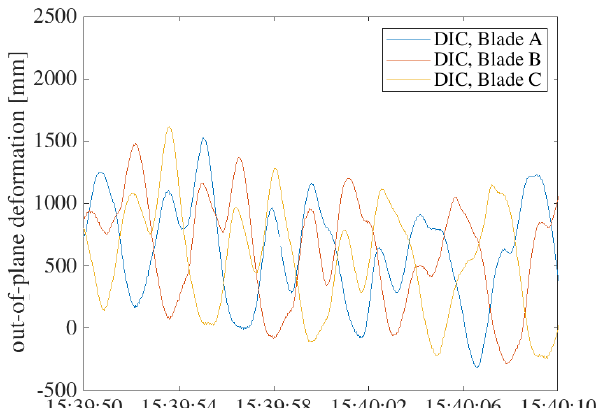
Figure 15. OoP DIC signal of all blades –